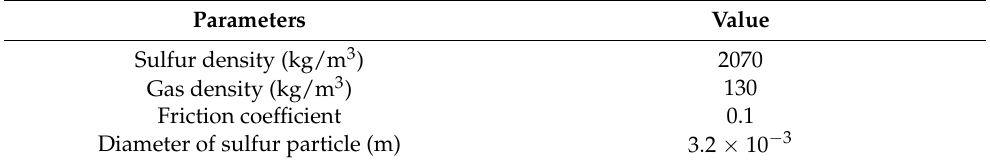
Table 3. Basic parameters used in critical carrying velocity model.